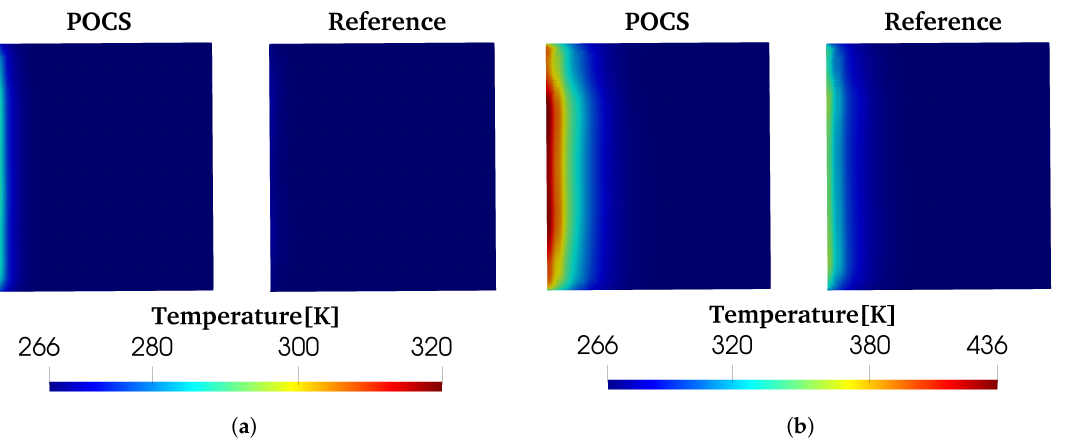
Figure 18. Cold start assessment: CAT1 temperature fields comparison—POCS vs. reference ATS: ( a ) time instant 3 s: half of the heating strategy; and ( b ) time instant 6 s: end of the heating